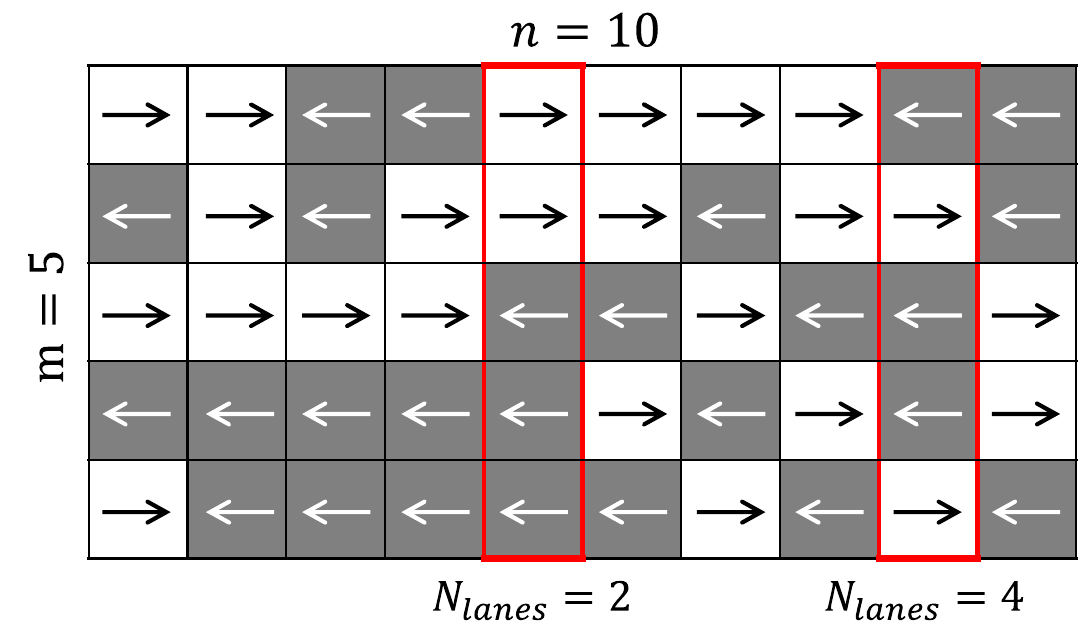
Fig 15. Grid used for the calculation of lanes. Bidimensional grid representing pedestrians moving in opposite directions in a counter flow. Lanes are counted for the two selected boxes.